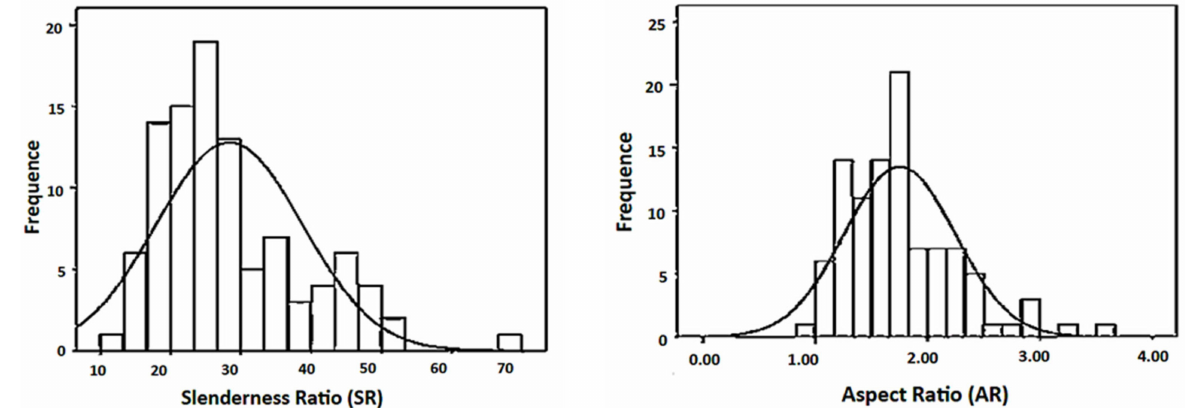
Figure 2. The distribution of the particles’ slenderness ratio and aspect